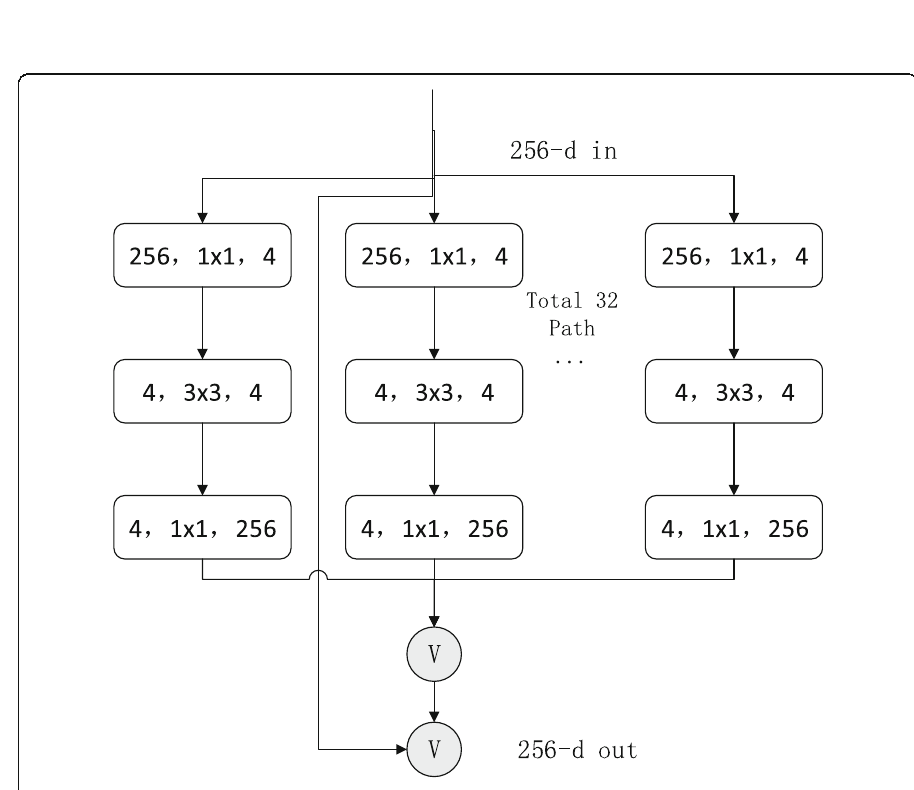
Fig. 5 Transform set